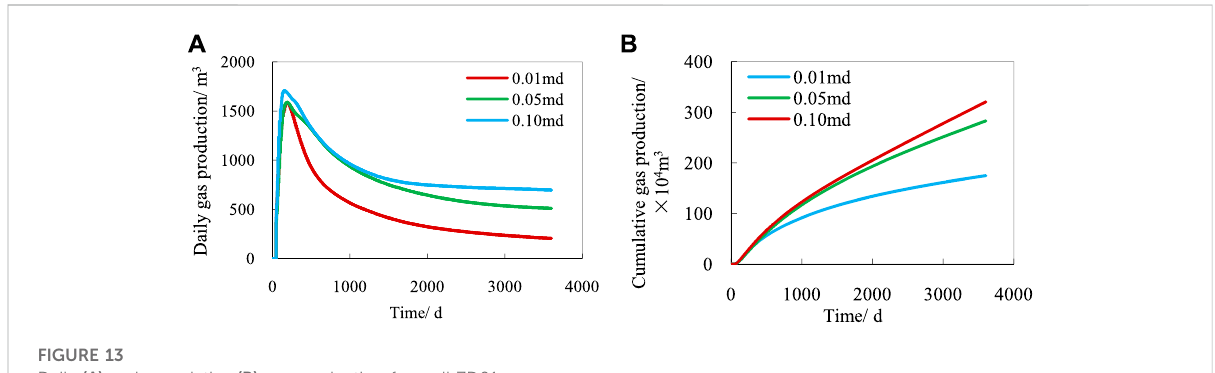
FIGURE 13 Daily (A) and cumulative (B) gas production for well